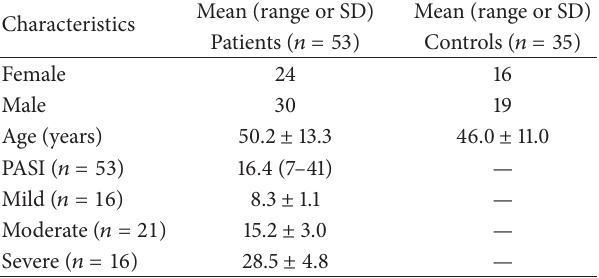
Table 1: Clinical features of psoriasis patients and healthy